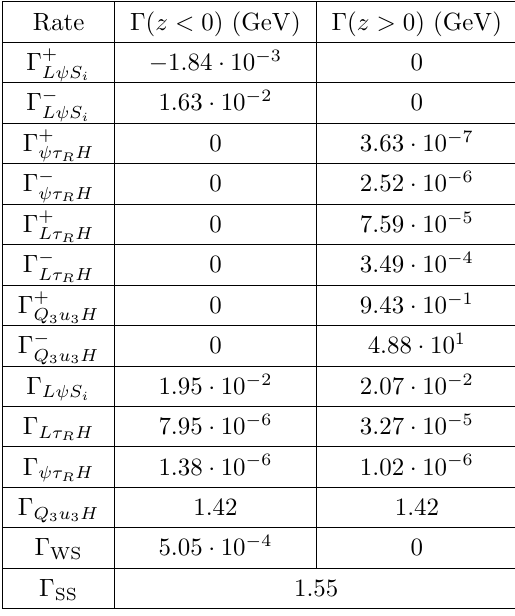
Table 11. Numerical values for reaction rates used when solving the transport equations for benchmark point